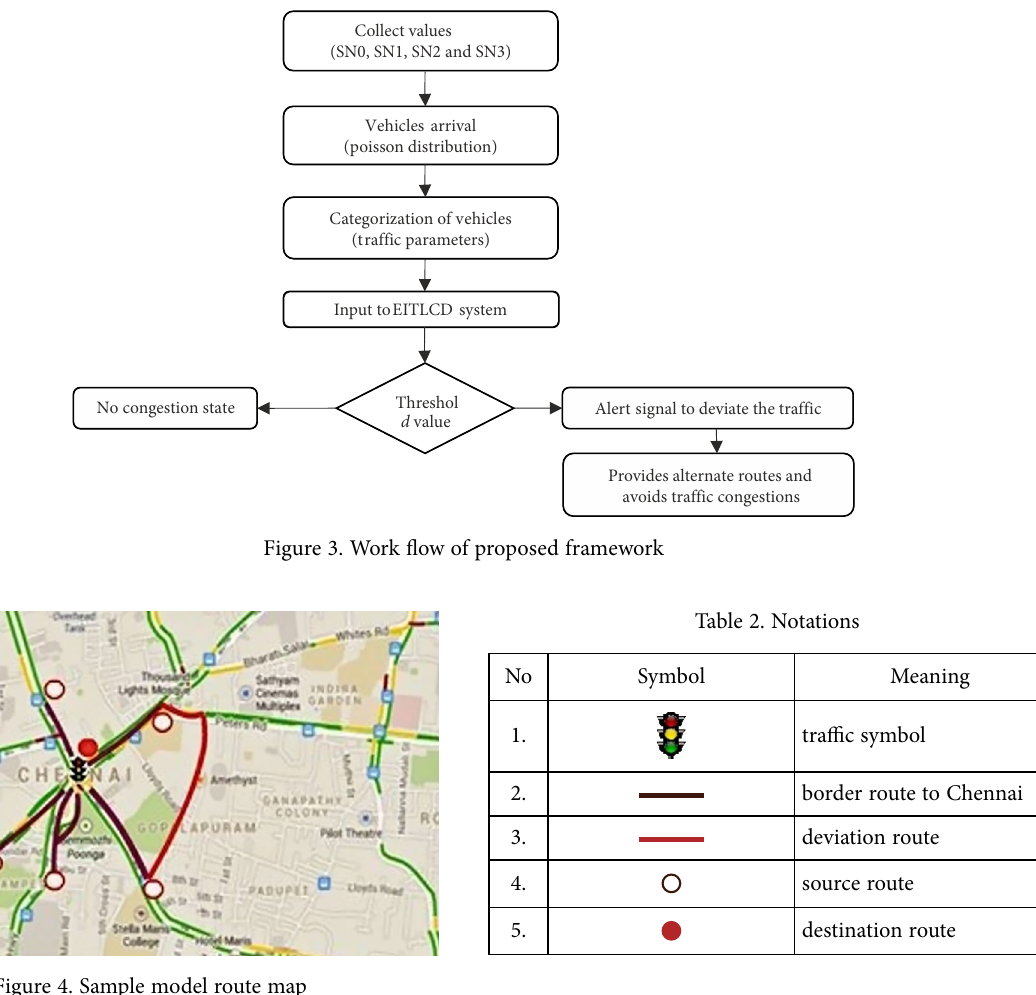
Figure 4. Sample model route map